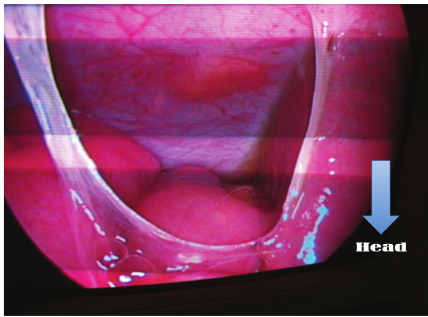
Figure 2: Laparoscopic view of appendicular appendicitis: adhe- sions and turbid liquids in peritoneal cavity.